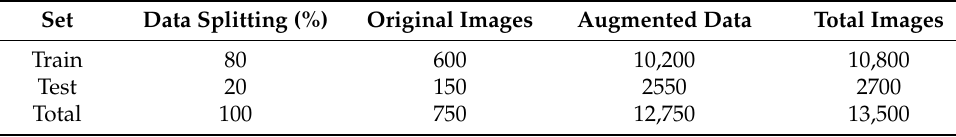
Figure 2. The DA method using image rotation and color manipulation. Table 1. Data splitting for training and testing in the proposed